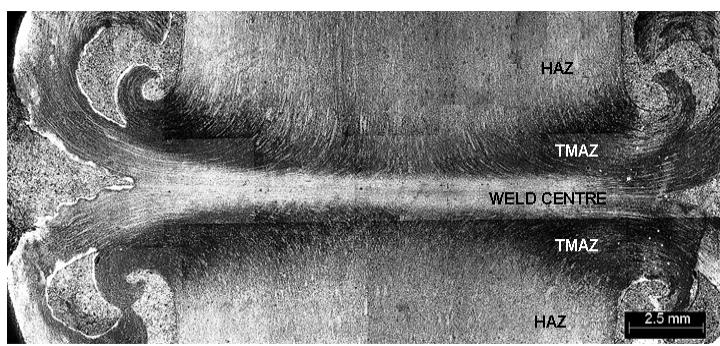
Figura 9: Micrografia a basso ingrandimento del cordone di saldatura LFW per AMC225xe.